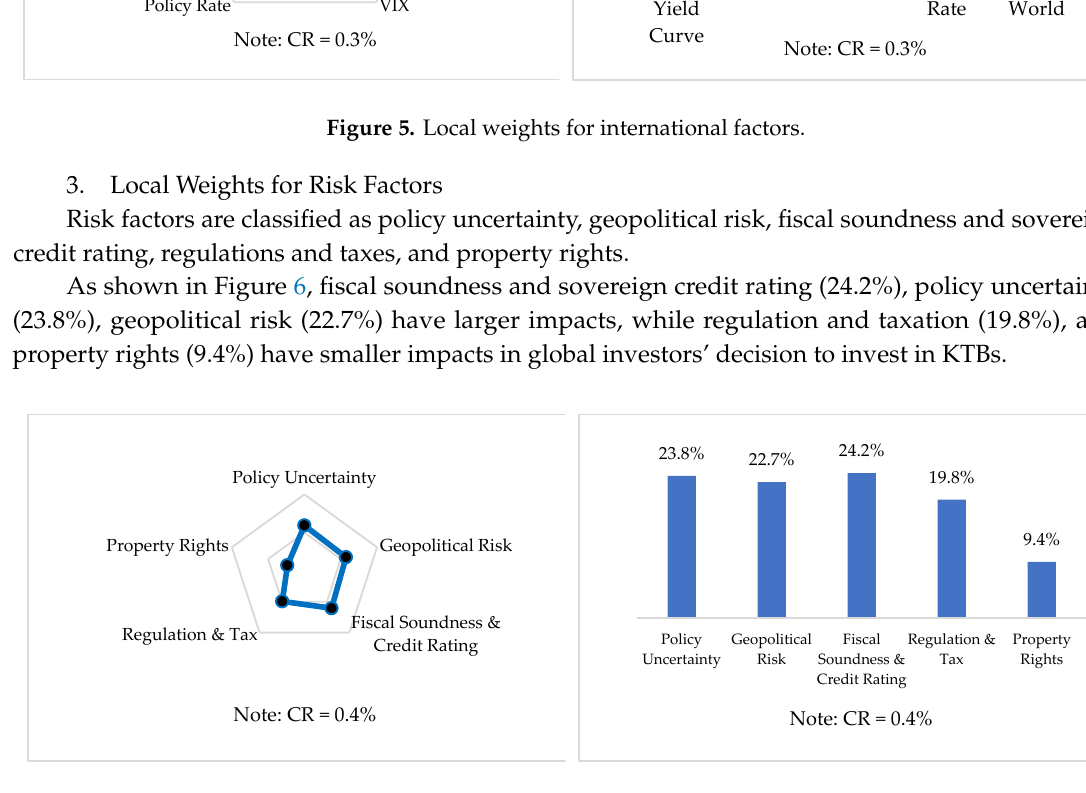
Figure 6. Local weights for risk factors.